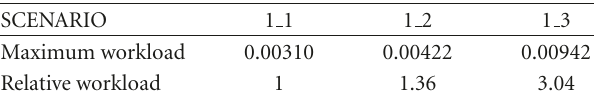
Table 8: Summary of performance evaluation 3 (st = 50 millisec-